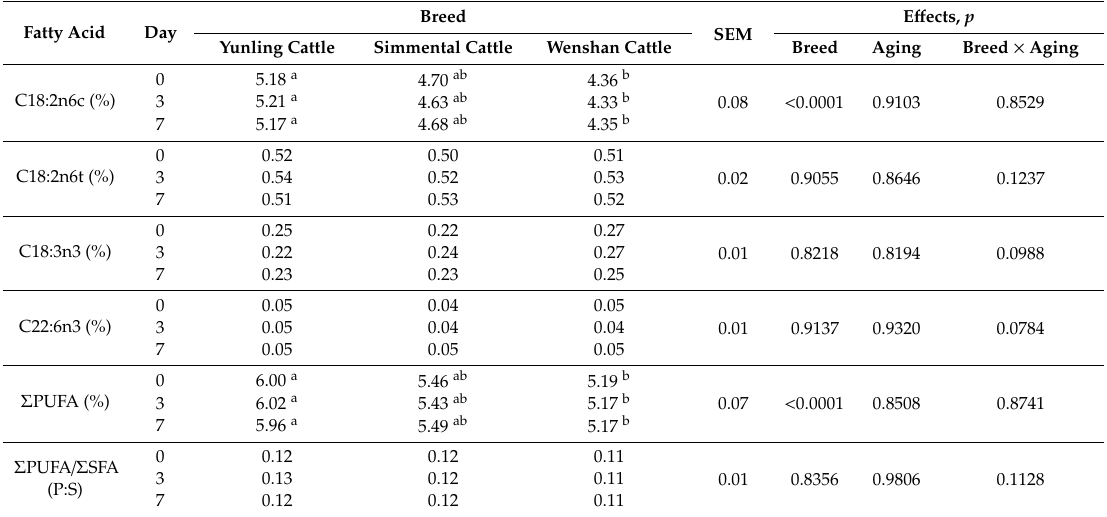
Table 9. The polyunsaturated fatty acids content a ff ected by breed and